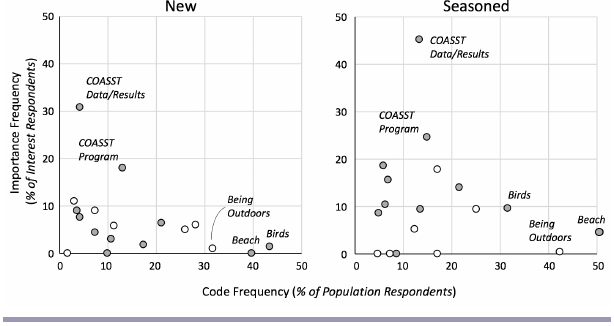
Fig. 3 . The co-occurrence of interest (objects: gray circles; actions: white circles) and importance, scaled equally across new and seasoned populations. The horizontal axis is the percent of the relevant responding population expressing a particular interest code; the vertical axis is the percent of that interest code population identifying the action or object as important. Interests in high frequency or importance quadrats are individually identified. COASST, Coastal Observation and Seabird Survey